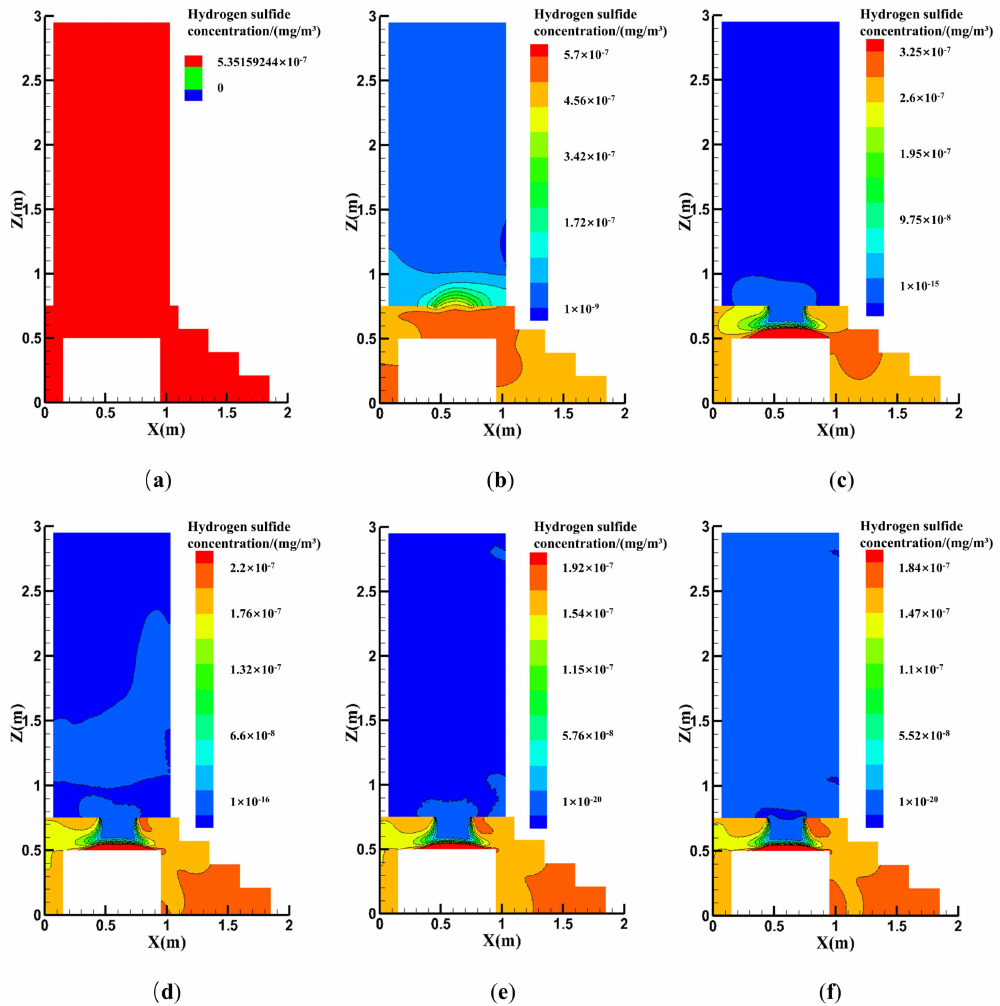
Figure 13. Hydrogen sulfide concentration distributions for different ACH (unit: h − 1 ) values (EFP-F 1 ). ( a ): ACH = 0; ( b ): ACH = 2; ( c ): ACH = 4; ( d ): ACH = 6; ( e ): ACH = 8; ( f ): ACH =